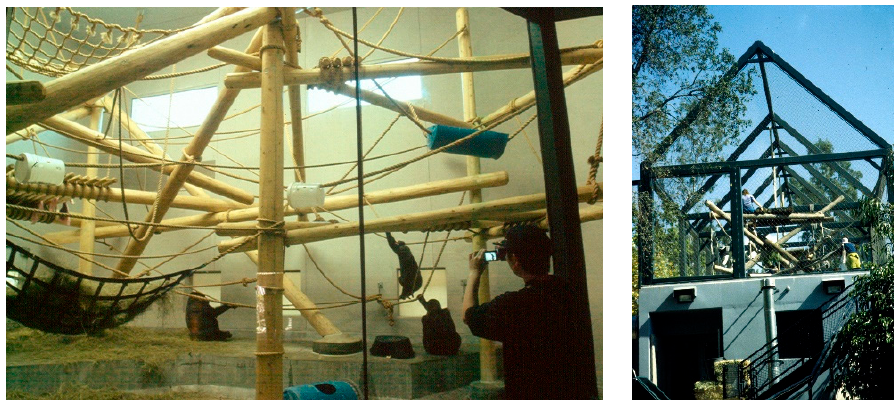
Figure 4. ( Left ) vertically oriented gorilla group room at Denver Zoo. ( Right ) Chimpanzee night building penthouse at Los Angeles Zoo (Photos: J. Coe).